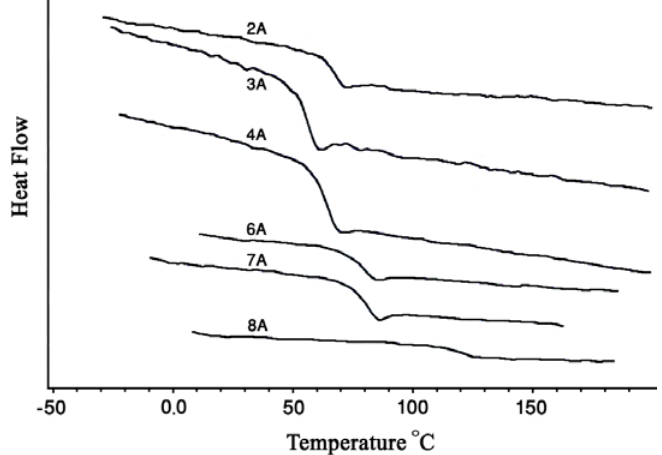
Figure 5. DSC Thermograms of polycarbonates (Series A).